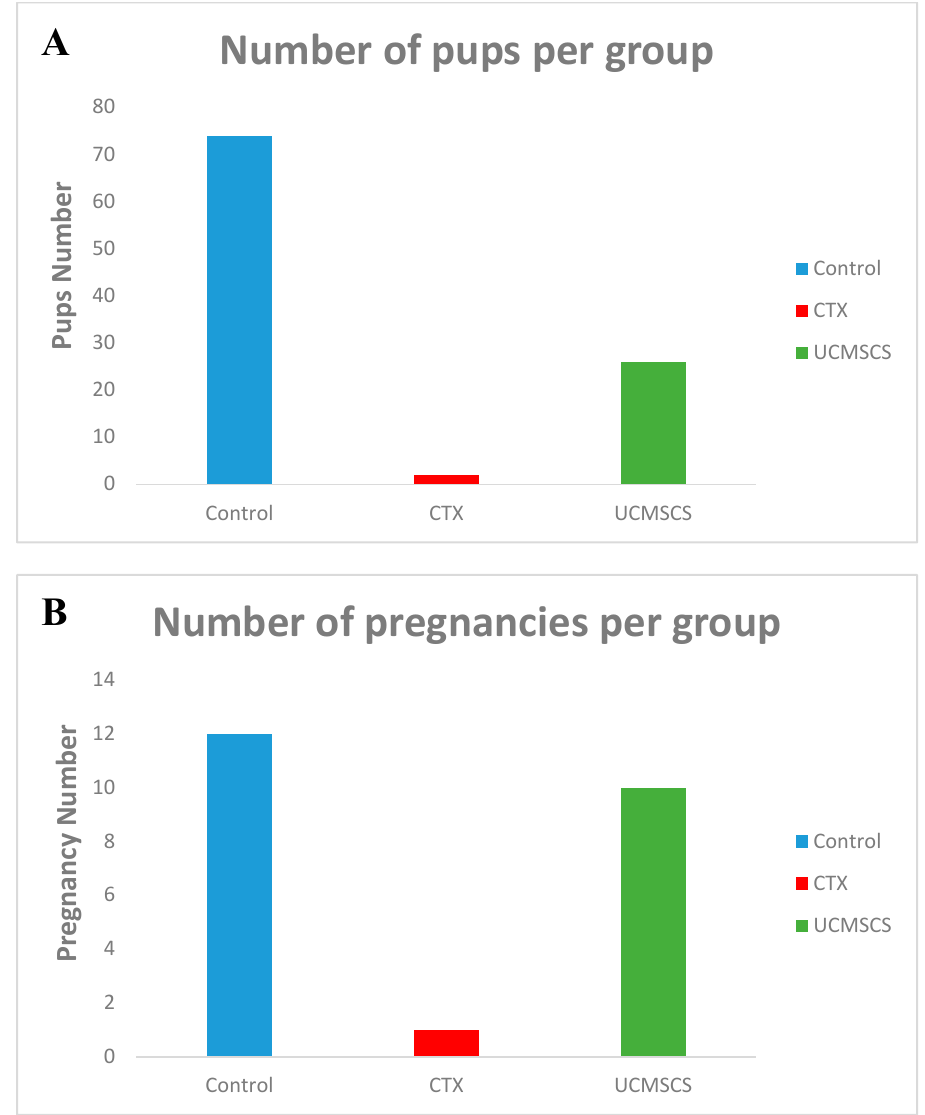
Figure 7. ( A ) Increase in number pf pups in UCMSCS group although not to the range of the control group; ( B ) The pregnancy frequency was in comparable to the control group.